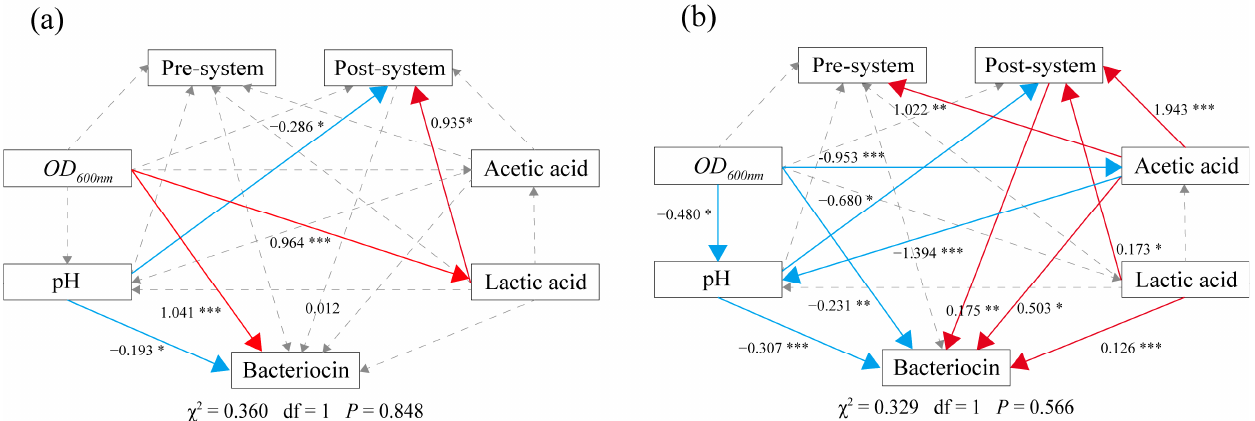
Figure 6. Pathway analysis of CFS and acetate-induced bacteriocin production. ( a ) CFS induces bacteriocin production. ( b ) Acetic acid induces bacteriocin production. The arrows show causality, and the dashed lines indicate nonsignificant correlations. The solid lines indicate significant differences at p < 0.05. The solid red line indicates a positive correlation, and the solid blue line indicates a negative correlation. Significance levels are as follows: *: p < 0.05, **: p < 0.01, ***: p < 0.001.